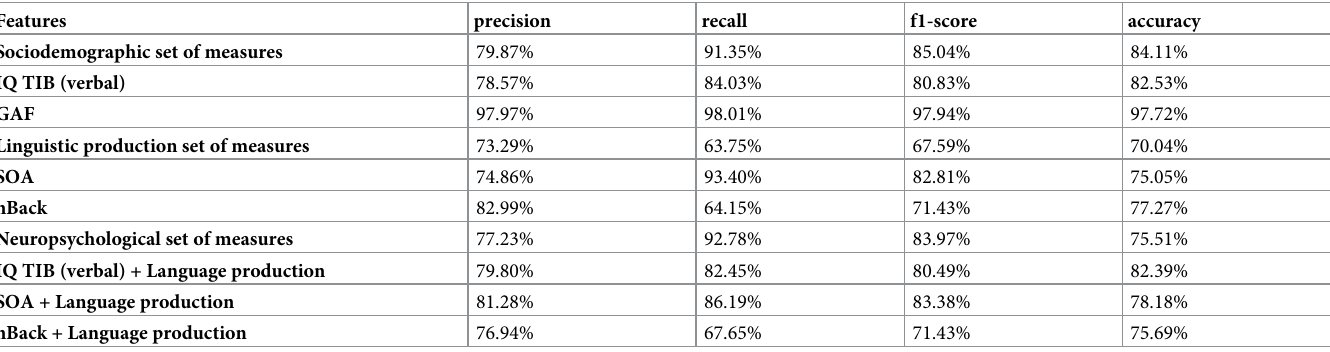
Table 7. XGBoost models precision, recall, f1-score and accuracy metrics by different predictive variables sets.